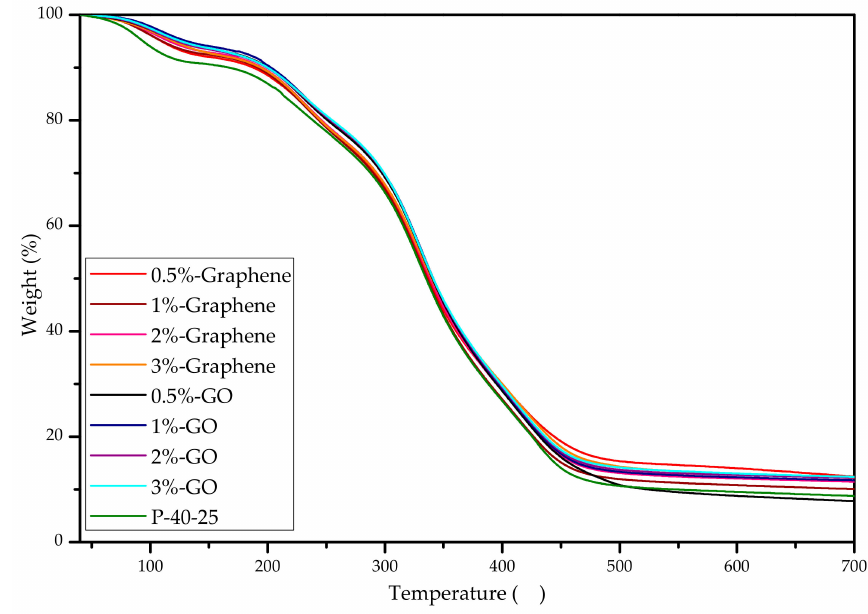
Figure 4. Thermogravimetric curves for P-40-25 incorporated with GO and